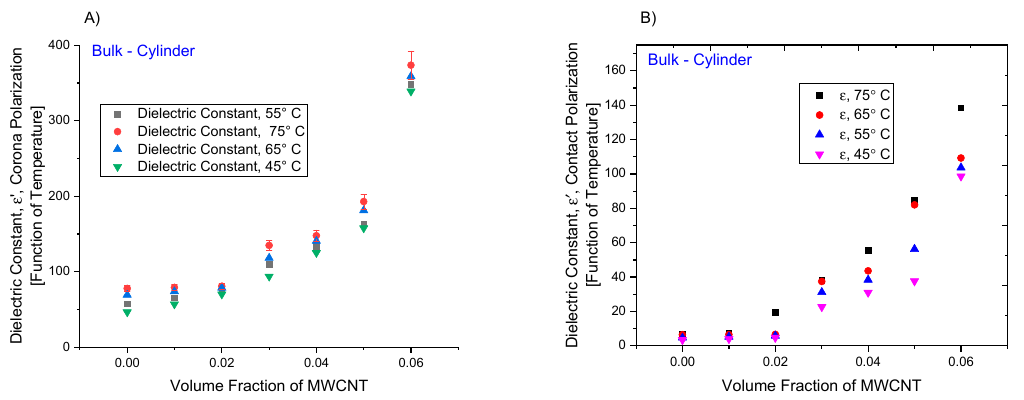
Figure 5. Variation in the dielectric constant as a function of temperature, volume fraction of MWCNTs, for ( A ) corona and ( B ) contact polarization techniques for bulk/disk samples.